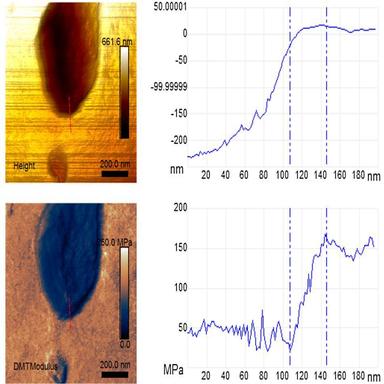
Topography (left) and dissipation energy (right) AFM nanomechanical mappings of the PBAT/il-TMP blend, revealing the dissipative nature of the nodules.